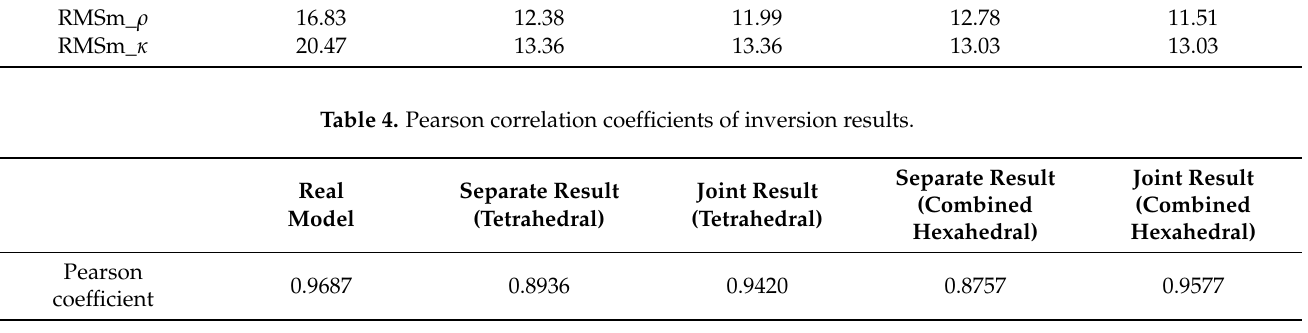
Figure 13. Slice of density (up) and magnetization (down) at y = 3500 m. ( a , f ) Real model; ( b , g ) separate result under tetrahedral grid; ( c , h ) joint result under tetrahedral grid; ( d , i ) separate result under combined hexahedral grid; ( e , j ) joint result under combined hexahedral grid.